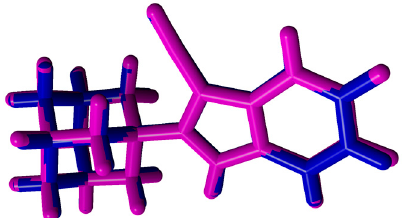
Figure 3. Atom-by-atom superimposition of DFT-optimized compound 1 (magenta) calculated using B3LYP/6-311++G (d,p) on the X-ray structure (blue) of 1 (RMSD = 0.143 Å). DFT: density functional theory.